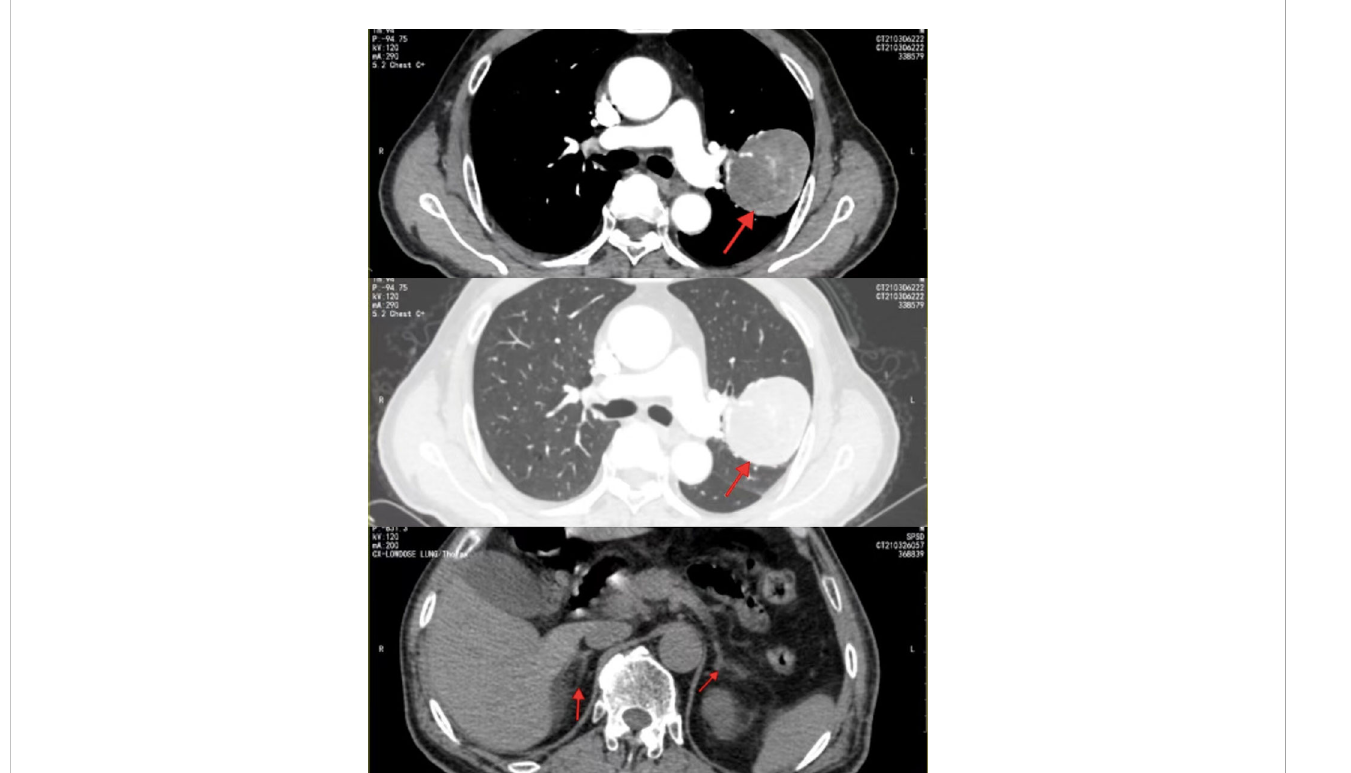
FIGURE 1 Contrast-enhanced CT revealed a heterogeneously enhancing solitary mass in the left lung;abdominal CT showed that the bilateral adrenal glands were normal in size and shape without abnormal